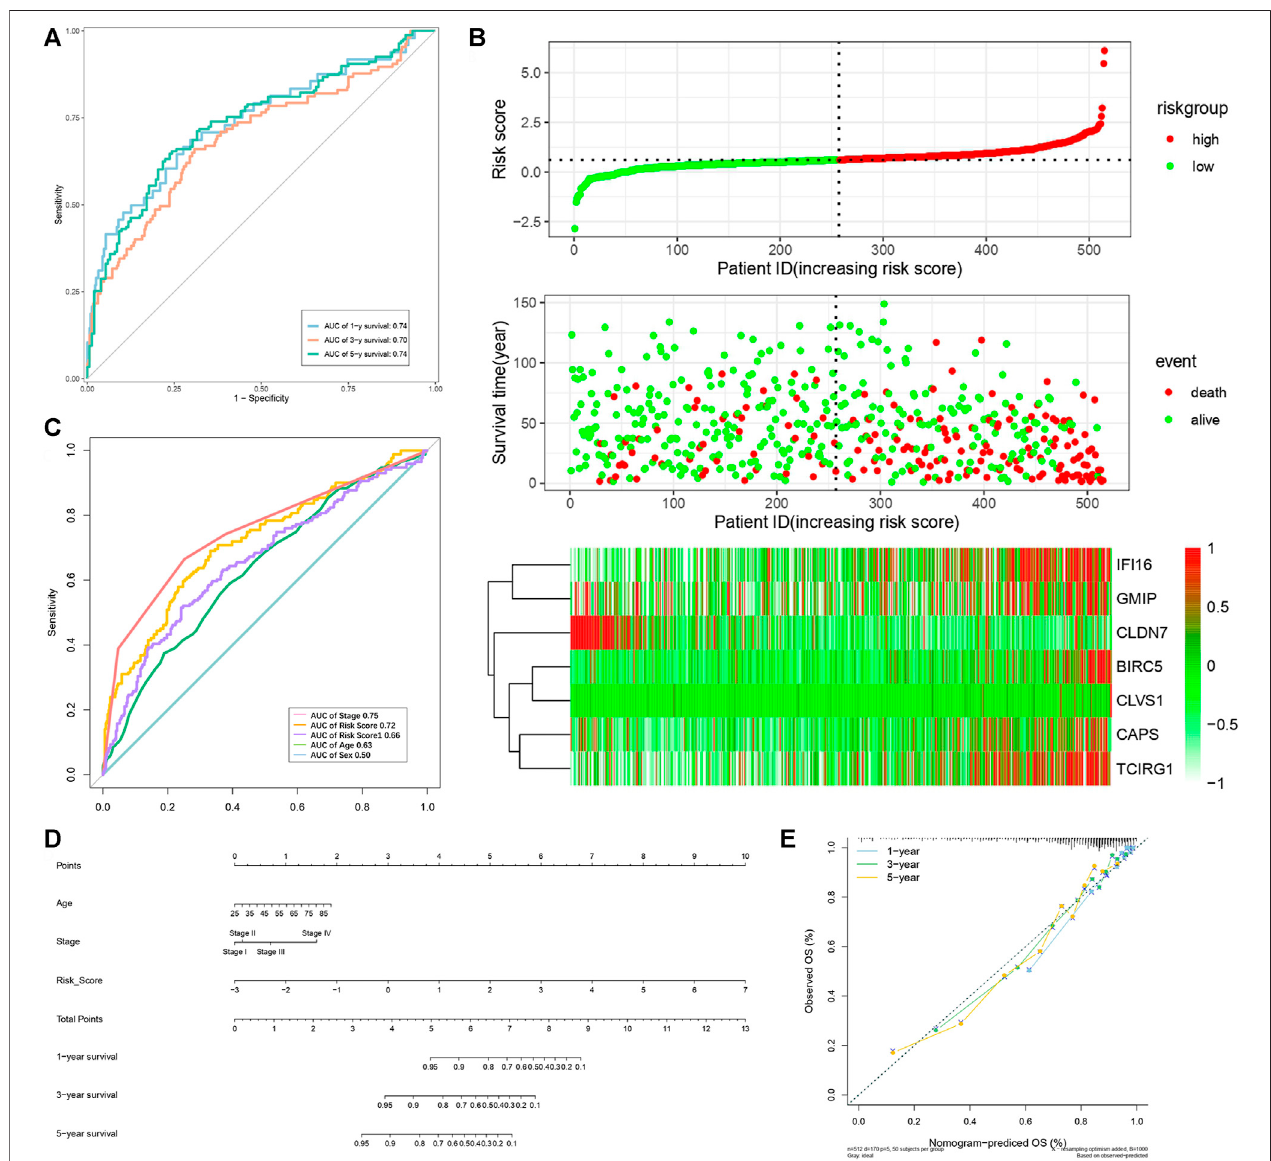
FIGURE 9 | Veri fi cation of risk score as predicting factor of ccRCC patients in total cohort. (A) Time-dependent ROC curve of 1-, 3-, 5-year. (B) ROC curve of clinical signatures of ccRCC patints. (C) Risk factor association diagram. Red nodes in the upper and middle graph represented patients with high risk score, green nodes represented patients with low risk score. Cells in the gram below represented each patients and color of cells indicated up- or down-regulation of genes. (D) Nomogram included age,stage, and 7gene-basedriskscore. (E) Calibration curvewasdepicted forveri fi cation accurancy ofnomogram predicting 1-,3-,5-years OS